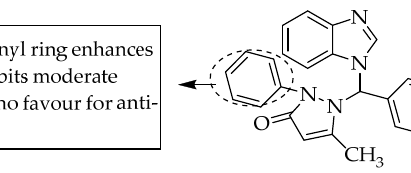
Figure 48. SARs of benzimidazol-1-yl (phenyl)methyl derivatives. Arora et al. (2014) suggested that electron-deficient groups (–Cl or –Br) favour, whereas electron-rich groups (–OCH 3 ) reduce, the anti-inflammatory potency of 2-acetamidobenzimidazoles. They also stated that the amide linkage in the molecule was not favourable for anti-inflammatory activity (Figure 49) [73].